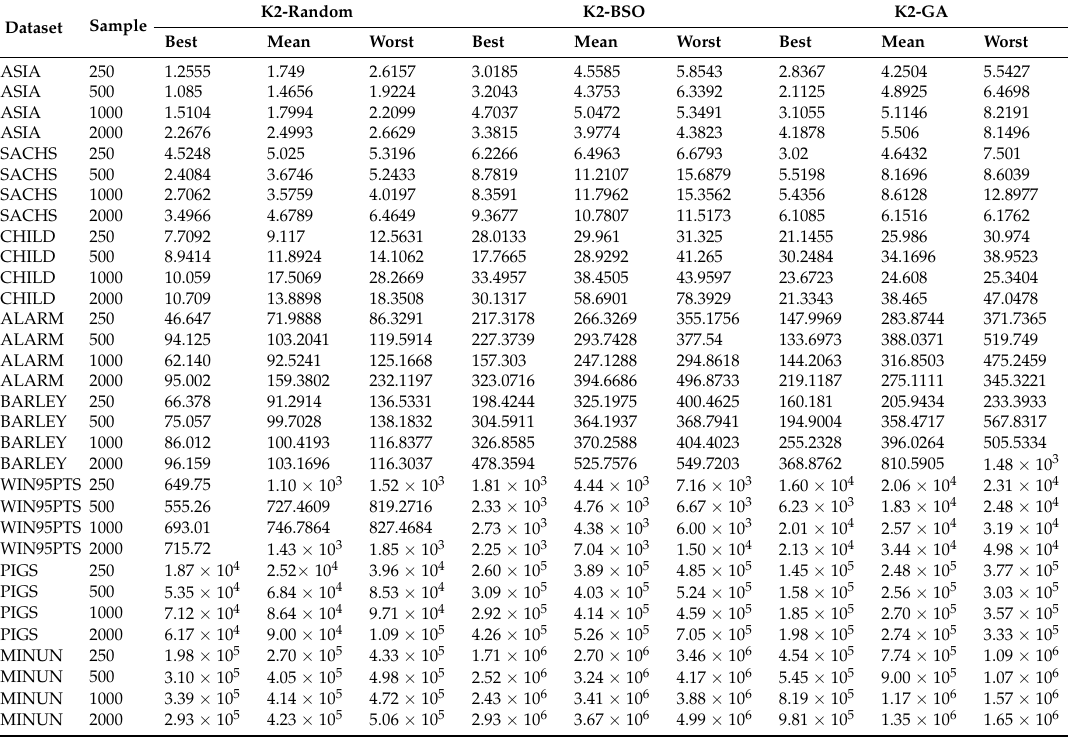
Table 3. Comparisons between three algorithms on execution